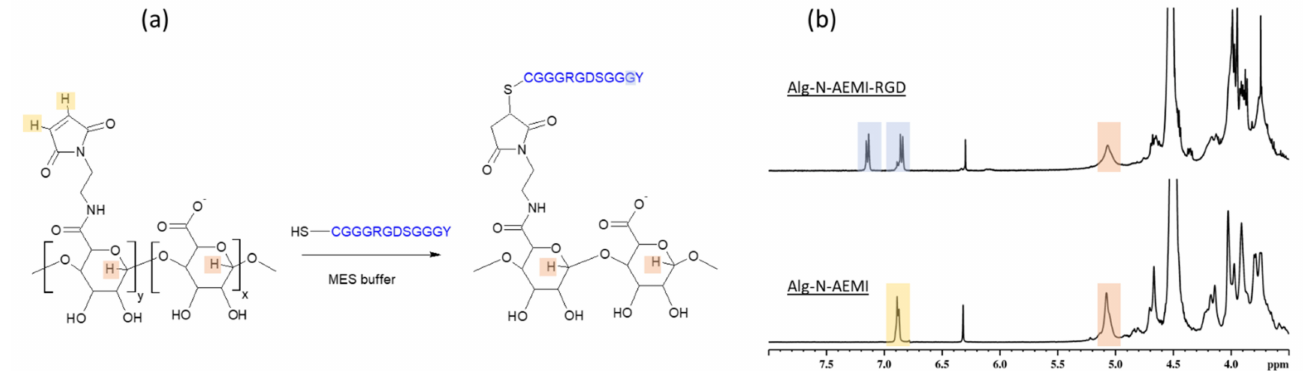
Figure 6. Peptide conjugation to alginate with help of thiol-Michael addition. ( a ) Scheme of the reaction; ( b ) 1 H NMR spectrum of Alg-N-AEMI measured in D 2 O at 50 ◦ C (bottom); 1 H NMR spectrum of Alg-N-AEMI-RGD measured in D 2 O at 50 ◦ C (top). Specific signals proving the modification are marked with color.